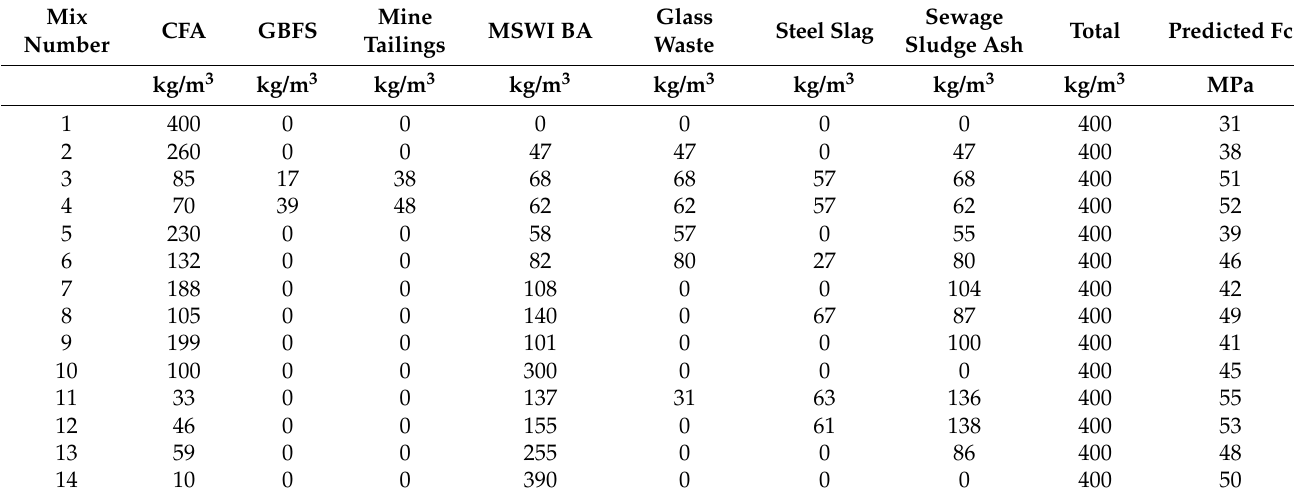
Table 1. Selected optimal mixes in Belgium.